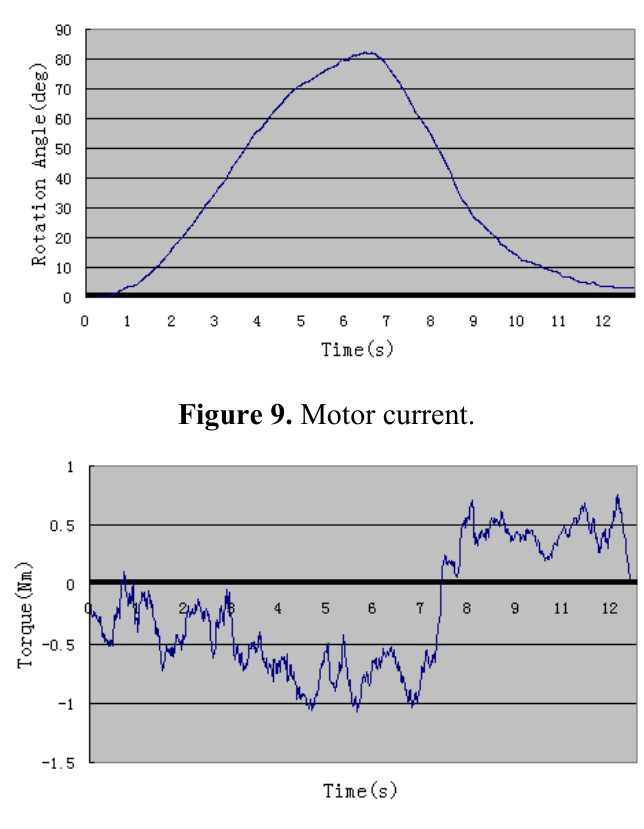
Figure 8. Rotational angle of the upper arm with the inertia sensor.